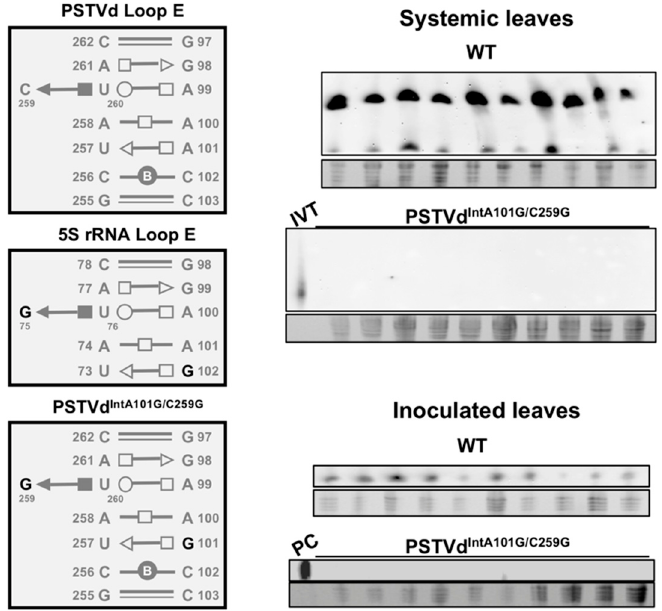
Figure 4. Loss of infectivity of a potato spindle tuber viroid (PSTVd) variant with 5S rRNA loop E sequences. Left panel displays loop E structural arrangements in wildtype (WT) PSTVd, N. benthamiana 5S rRNA, and a loop E swapped PSTVd IntA101G/C259G . The right panel shows northern blots detecting the infection of WT PSTVd and PSTVd IntA101G/C259G in local and systemic leaves of N. benthamiana plants. PC, a verified RNA sample from PSTVd-infected leaves served as a positive control. IVT, the unit-length in vitro transcript served as a control. Note: only circular PSTVd (an indicator of replication) is shown in the northern blots for inoculated leaves. The “ 〇 , ⎕ , ∆ ” symbols depict Watson-Crick, Hoogsteen, and sugar edges, respectively. The hollow and solid symbols represent trans and cis glycosidic orientations, respectively. These symbolic annotations of loop E 3-dimensional structures were previously explained in detail [63,65].